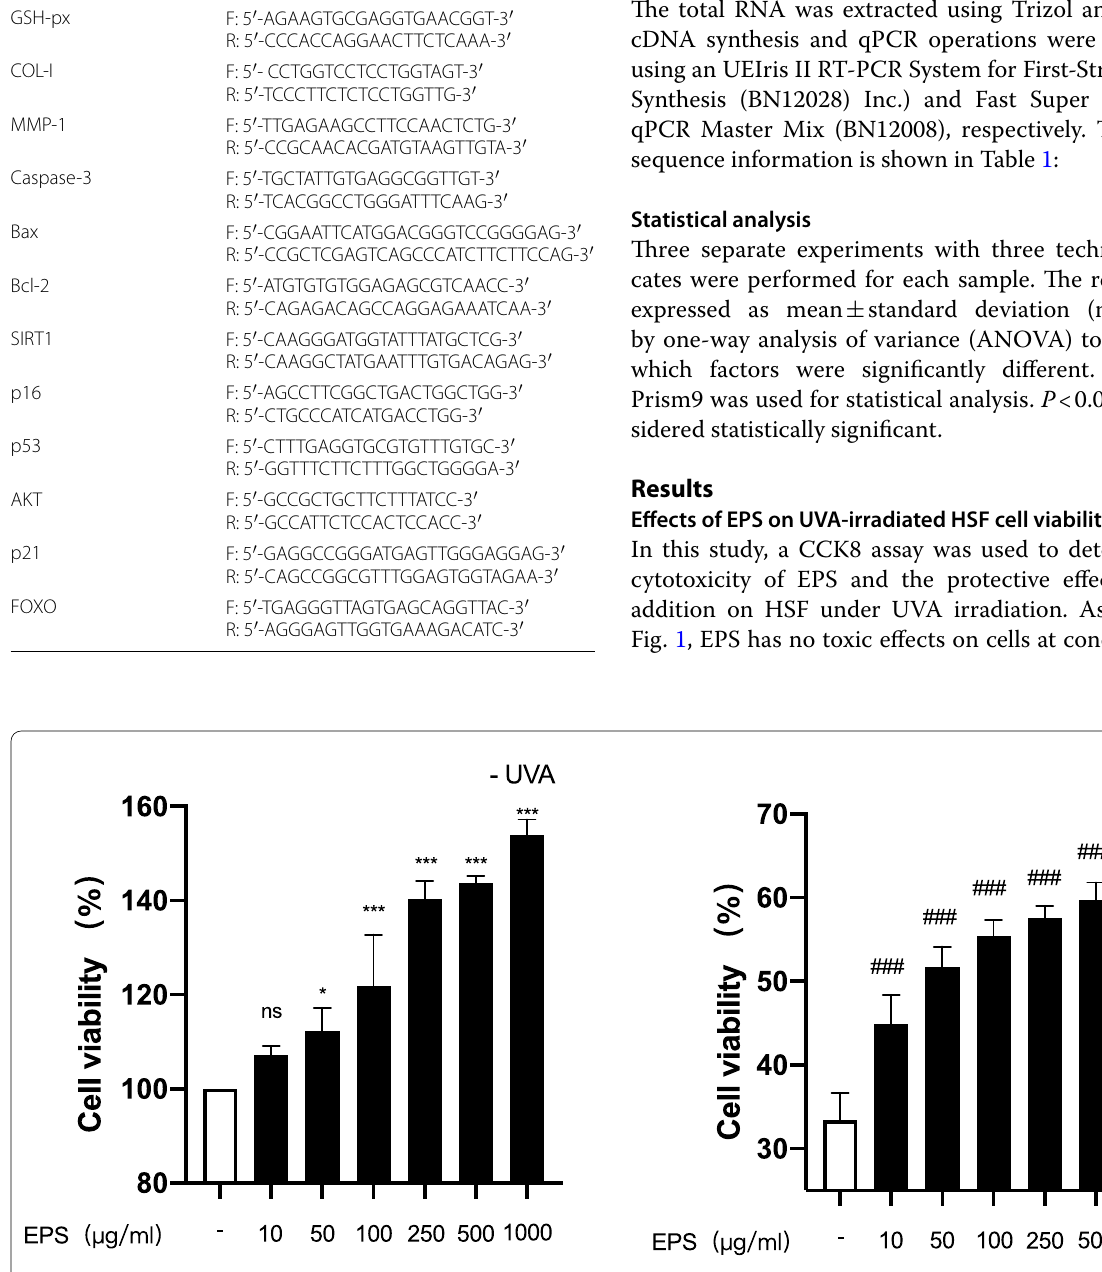
Fig. 1 Effects of different concentrations of EPS on HSF survival rate under normal conditions and after UVA irradiation. * p < 0.05, ** p < 0.01, *** p < 0.001 compared to untreated control group; # p < 0.05, ## p < 0.01, ### p < 0.001, compared to model